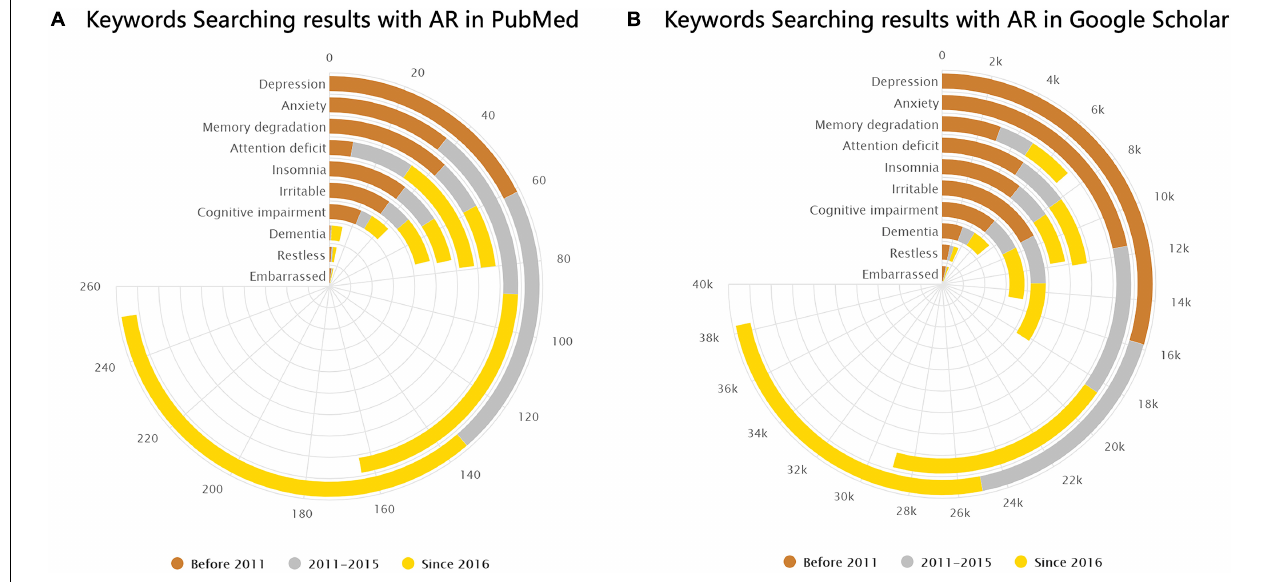
FIGURE 7 | Keyword search results in PubMed and Google Scholar. (A,B) Number of results from PubMed and Google Scholar (by February 2021) shown separately for the following keywords: “(allergic rhinitis) AND (depression),” “(allergic rhinitis) AND (anxiety),” “(allergic rhinitis) AND (memory degradation),” “(allergic rhinitis) AND (attention deficit),” “(allergic rhinitis) AND (insomnia),” “(allergic rhinitis) AND (irritable),” “(allergic rhinitis) AND (cognitive impairment),” “(allergic rhinitis) AND (dementia),” “(allergic rhinitis) AND (restless),” and “(allergic rhinitis) AND (embarrassed).”